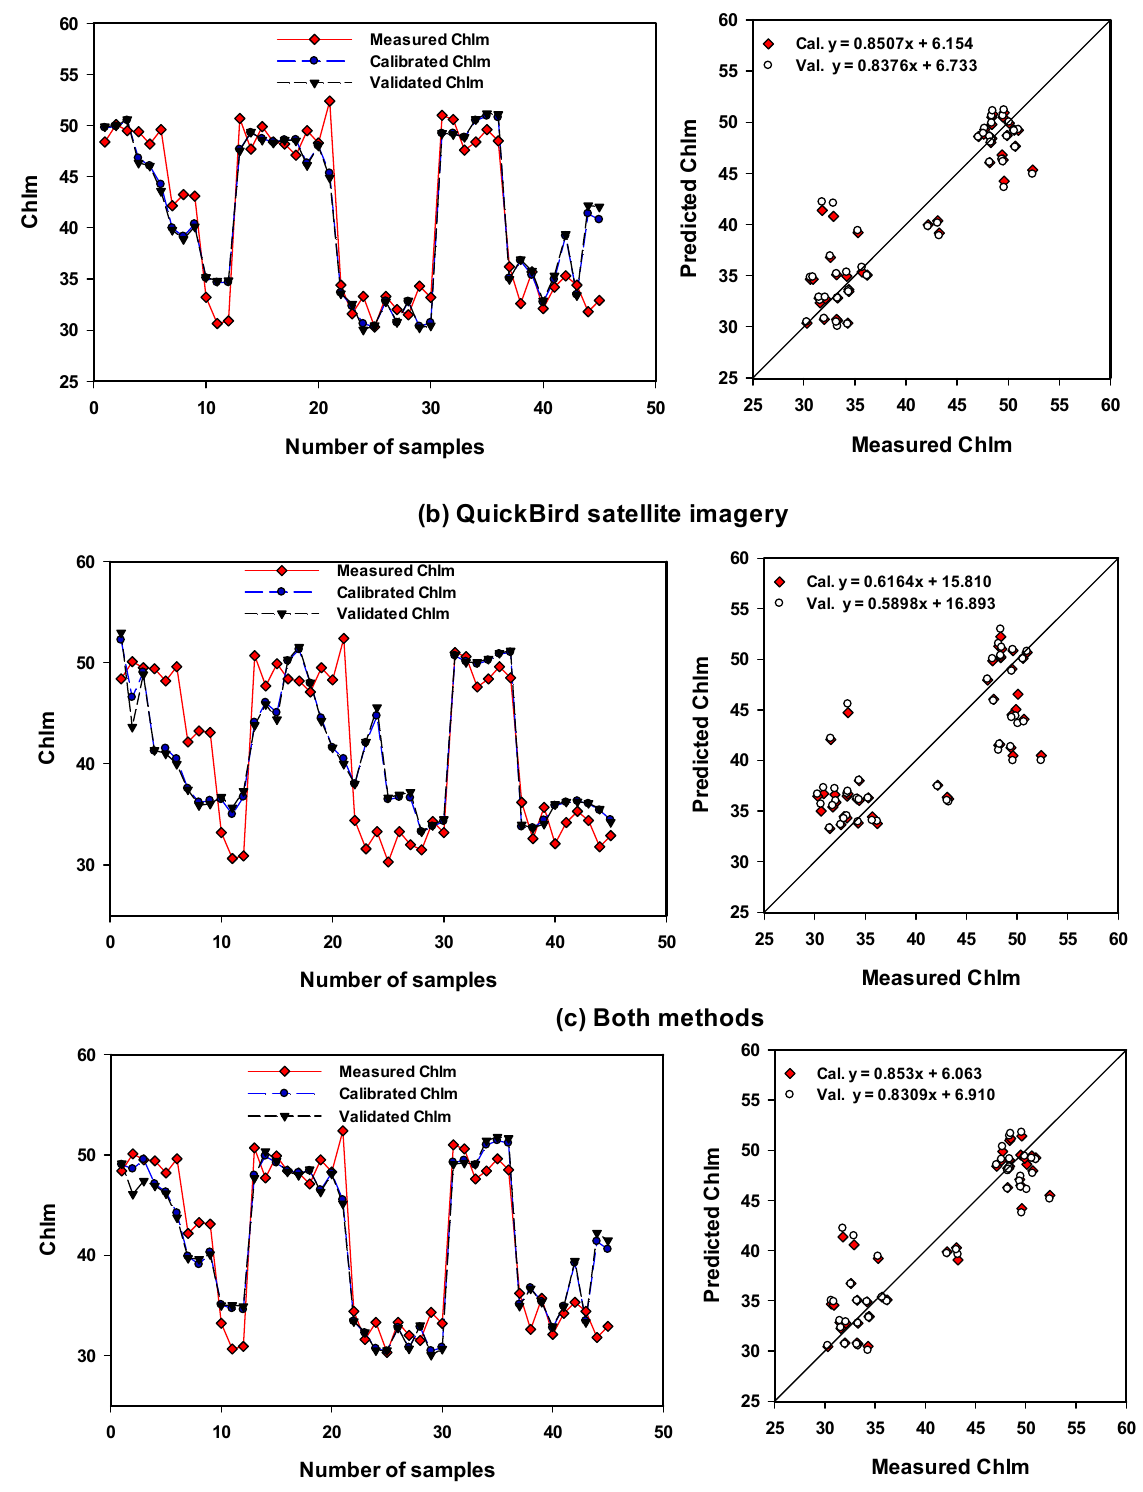
Figure 5. Comparison between measuring series, calibrating series and validating series for chlorophyll meter (Chlm) of maize using the PLSR models based on selected vegetation-(SRIs) extracted from (a) radiometric ground-based data, (b) extracted from QuickBird satellite imagery, and (c) extracted from both methods.